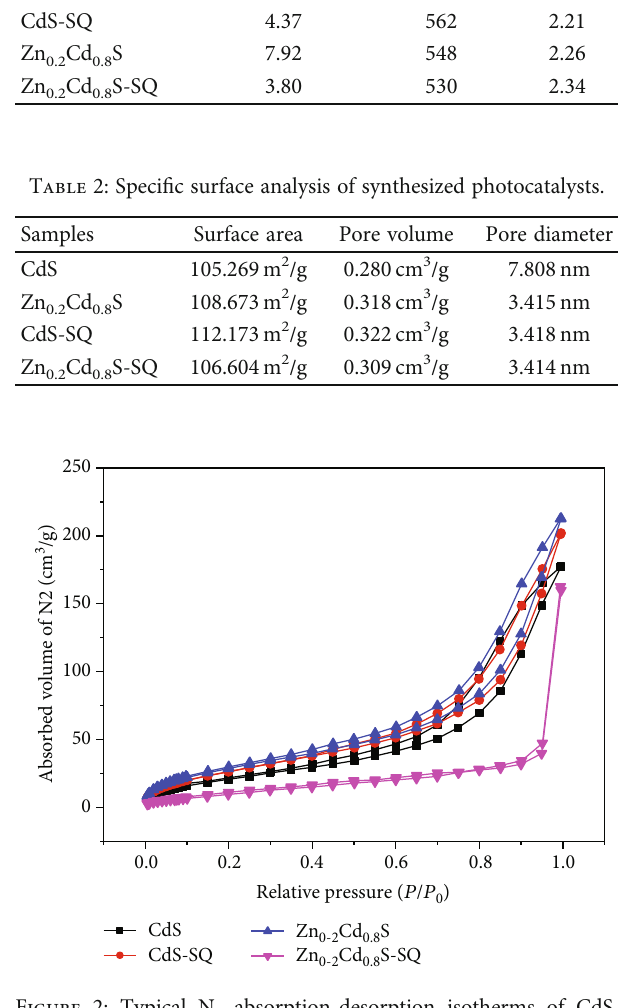
Figure 2: Typical N absorption-desorption isotherms of CdS, 2 CdS-SQ, and obtained with coprecipitation method and assisted with sonochemical prepared